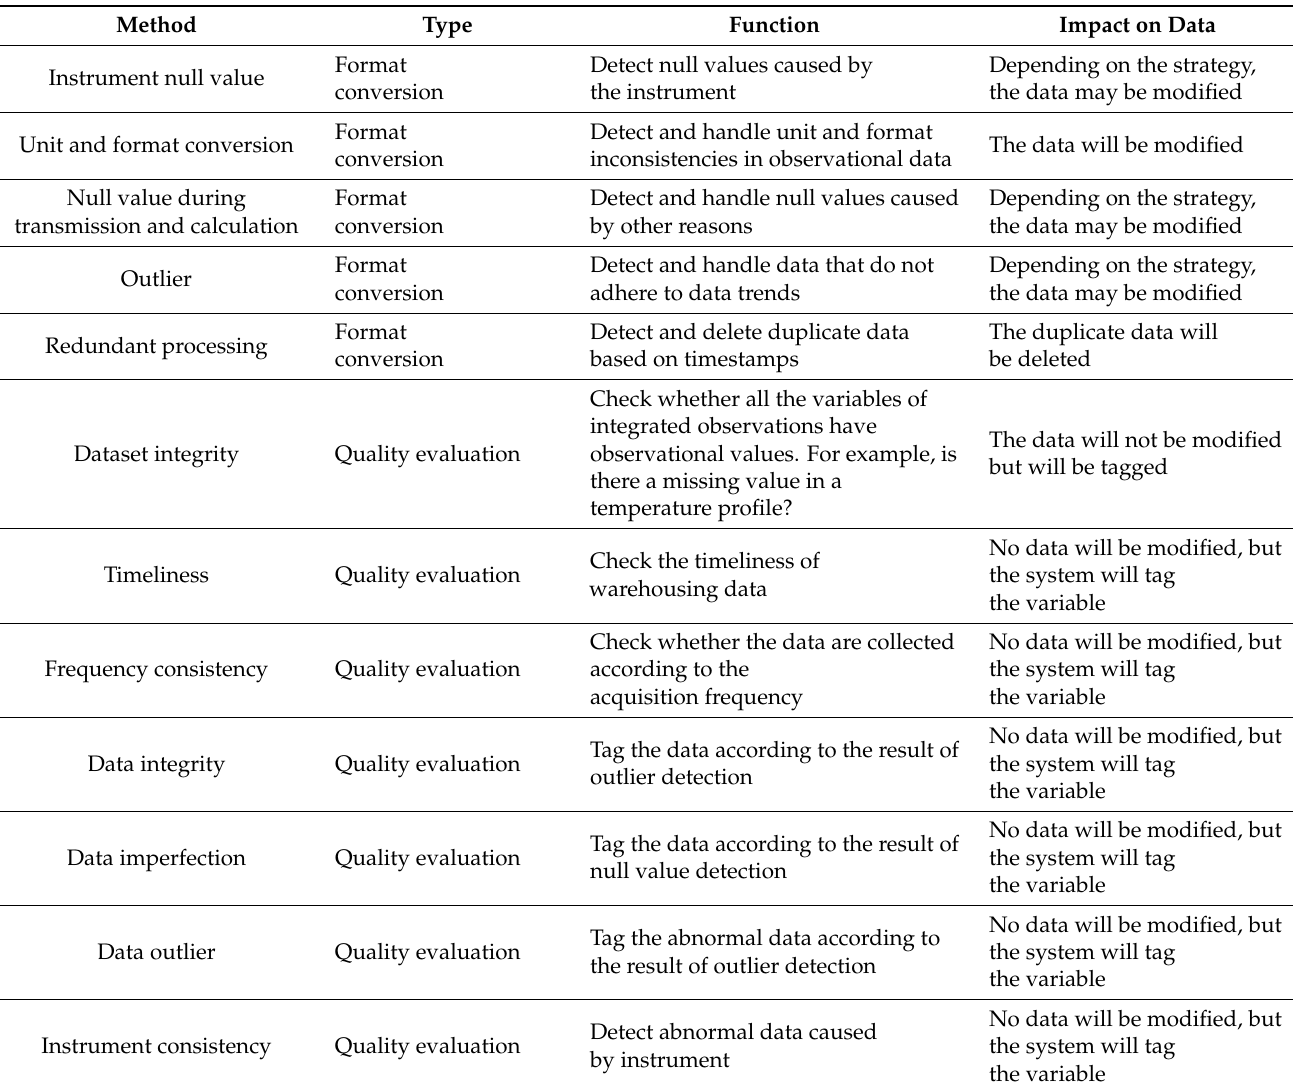
Table 2. Format conversion and quality evaluation methods used in the IODCS